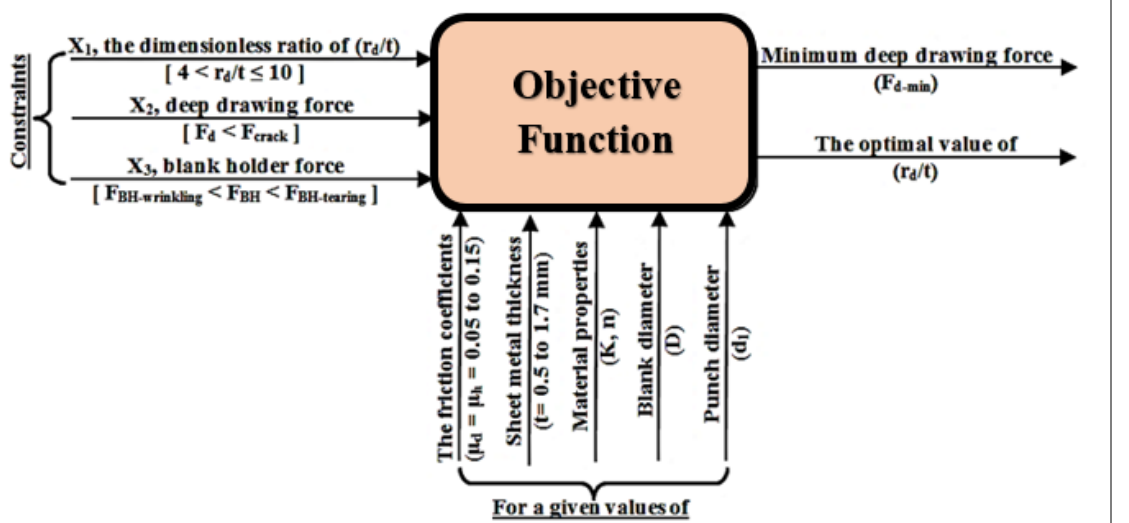
Figure 10. Layout of the operating parameters in the objective function.